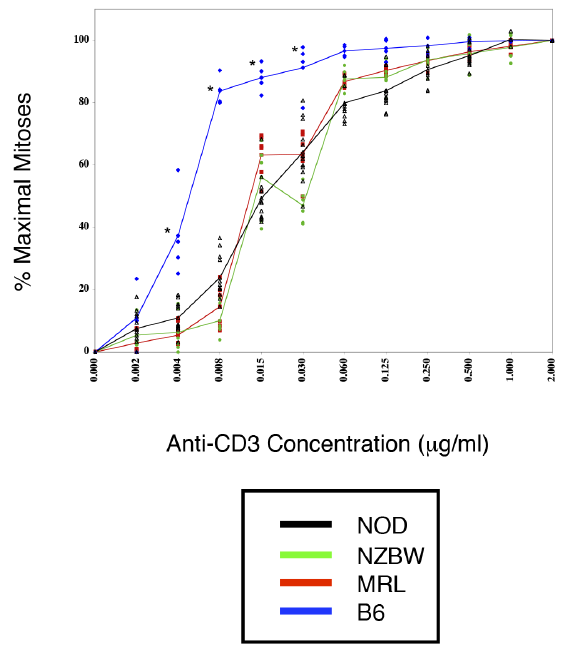
Figure 2. Dose responsiveness of autoimmune CD4 T cells to anti-CD3 mediated stimulation. The number of mitoses per 10,000 CD4 T cells was determined for cultures stimulated with a range (0– 2 m g/ml) of anti-CD3 concentrations; each culture received 4 m g/ml anti-CD28. The percent of the maximal mitosis is shown plotted against the dose of anti-CD3. The autoimmune strain CD4 T cells exhibit dose- response curves that are less responsive than the normal control B6. Significant differences in response are noted at the lower concentra- tions of anti-CD3 (*p , 0.01, B6 vs all other strains, ANOVA followed by Bonferroni post-test). It is important to note that 100% represents the maximal number of mitoses achieved by that strain; the maximum for the normal strain B6 is greater than that for the autoimmune strains. Data are from three separate experiments (n . 6 for all strains).